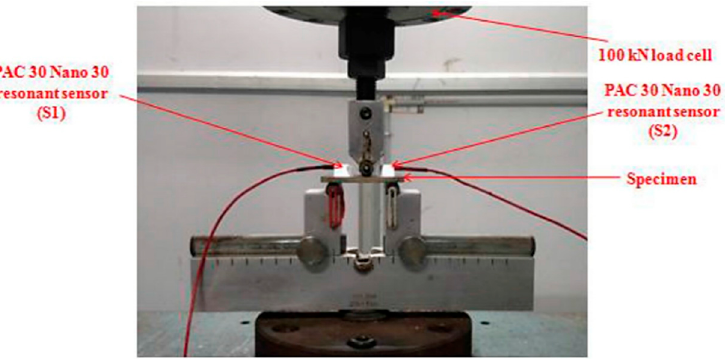
26 of 42 Figure 13. XRD-graph of kenaf/epoxy composites and filler-filled kenaf/epoxy hybrid nanocompo- sites [179] (Reprinted/adapted with permission from Elsevier Ref.501782938 Copyright 2018). 8. Application of Non-Destructive Testing in Epoxy-Based Natural Fiber Polymer Composites The application of non-destructive testing has gained huge acceptance in polymer composites. Numerous research studies have applied the usage of non-destructive test- ing in evaluating the validity of test materials such as the one found in epoxy-based nat- ural fiber polymer composites. Idolor et al. [180] used non-destructive testing to examine polymer composites by exploring the polymer–water interface and damage-dependent hysteresis. In this research, moisture, which served as an imaging agent, is naturally ab- sorbed in the polymer composite for damage detection, and with the use of machine learning (logistic regression), damaged and undamaged regions were classified. Kumar et al. [181] used the acoustic emission (AE) technique to investigate the temperature and hybridization effect on the drop weight impact and post-impact residual strength of re- inforced hemp and basalt polymer composite laminates. The composites at temperatures of 35 °C and 65 °C were first subjected to a drop weight impact, which was later fol-